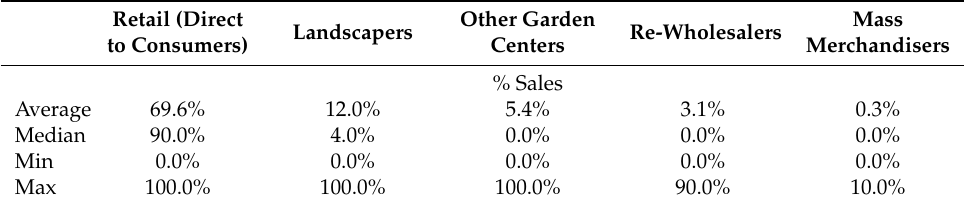
Table 2. Distribution of 2014 business sales, across marketing channels, of ornamental horticulture industry respondents in the study